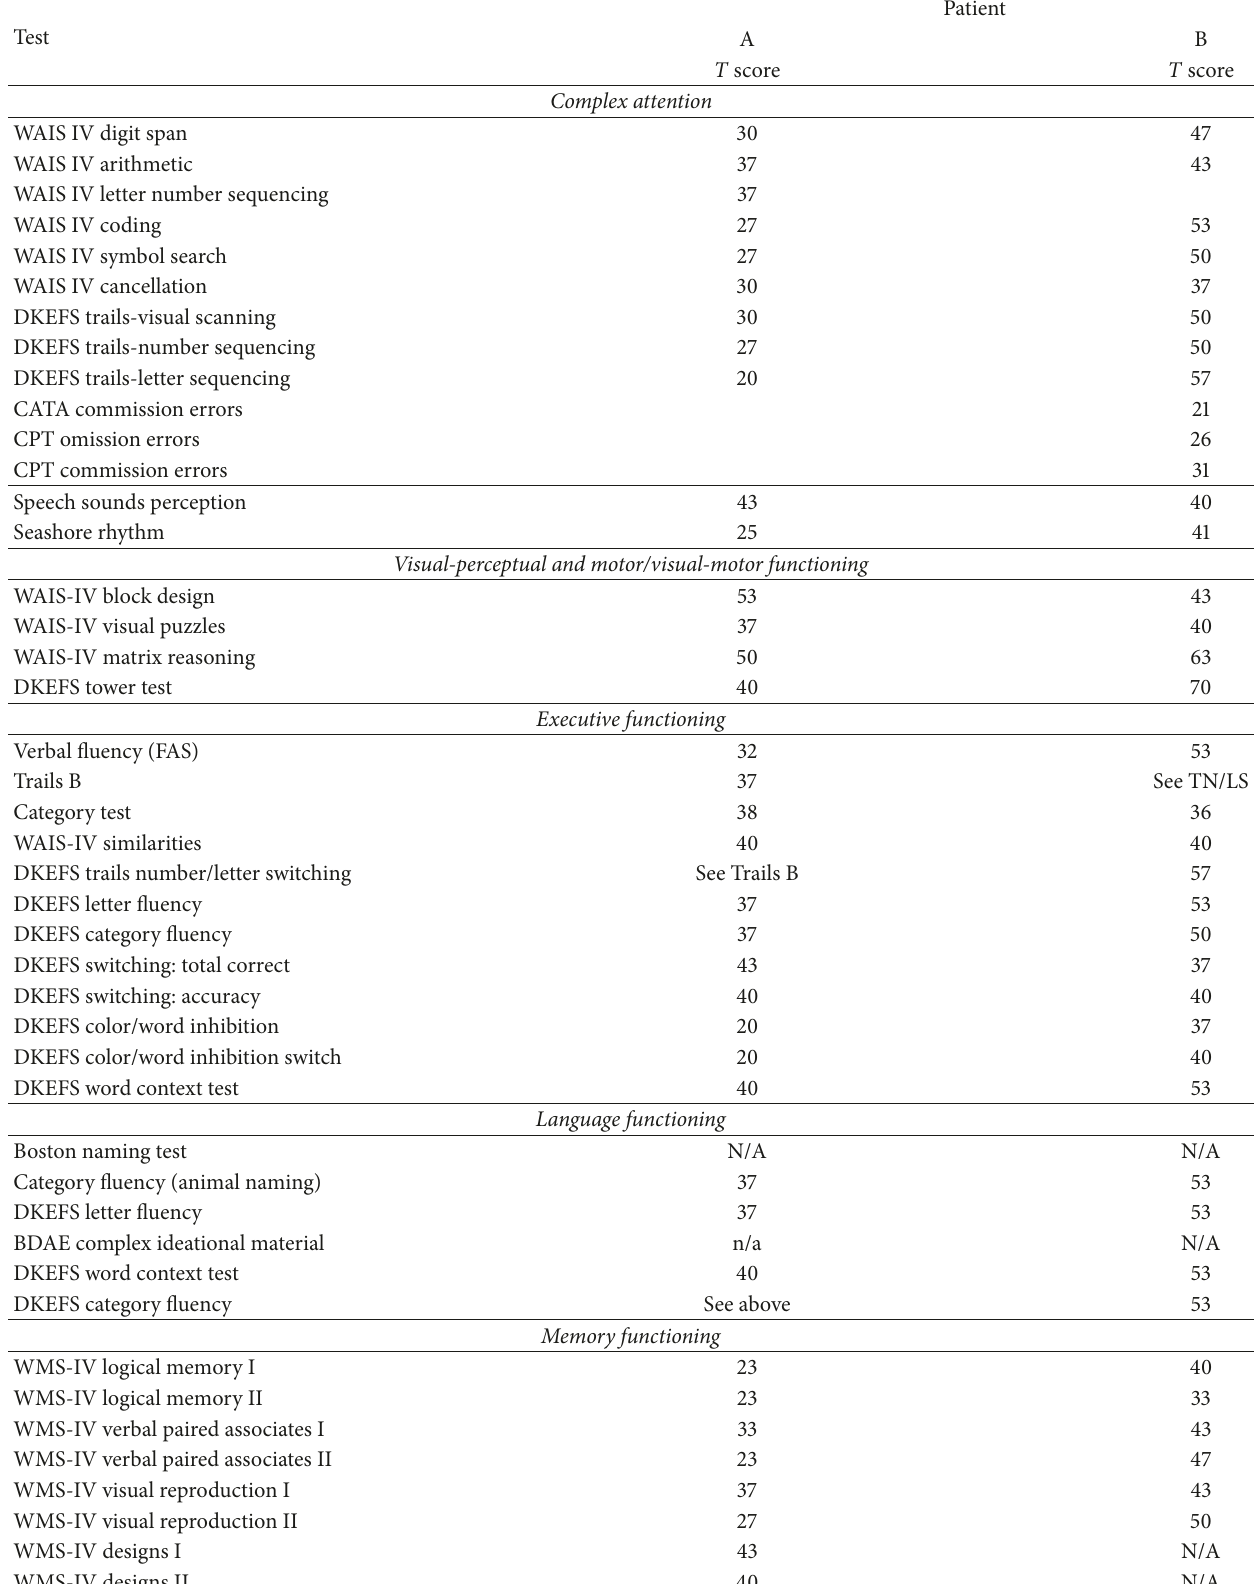
Table 2: Neuropsychological testing results. Patient neuropsychological testing showing impaired memory and cognitive functions